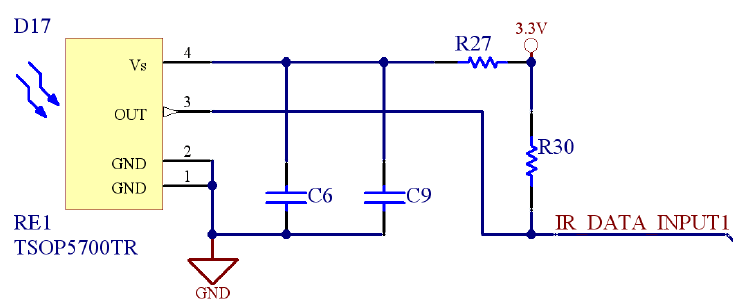
Figure 7. Schematic of one data reception